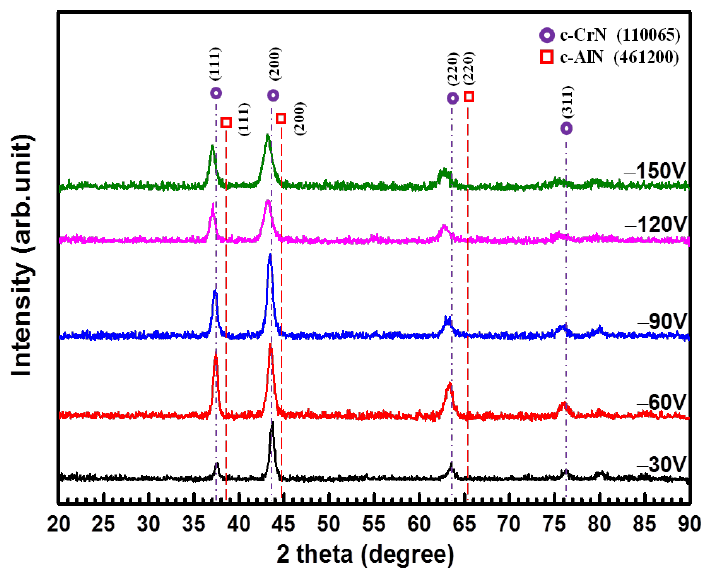
Figure 6. GIXRD profiles of CrAlN layers formed under various bias voltages.